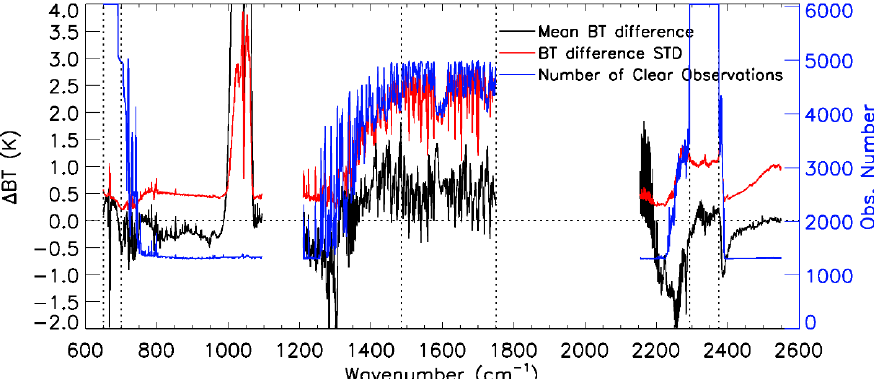
Figure 4. The brightness temperature difference between NOAA-20 CrIS observation and simulation with COSMIC-2 RO data for clear channels over oceans during June 2021.